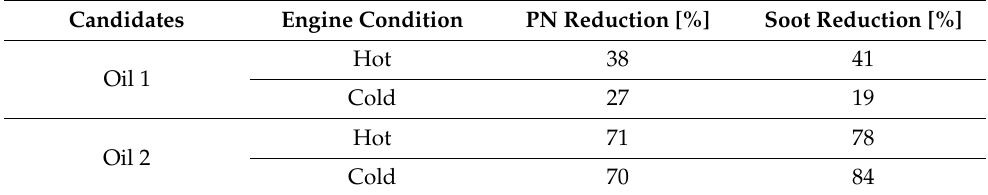
Table 7. Candidates ’ PN/Soot percentage reduction vs. the Reference oil.